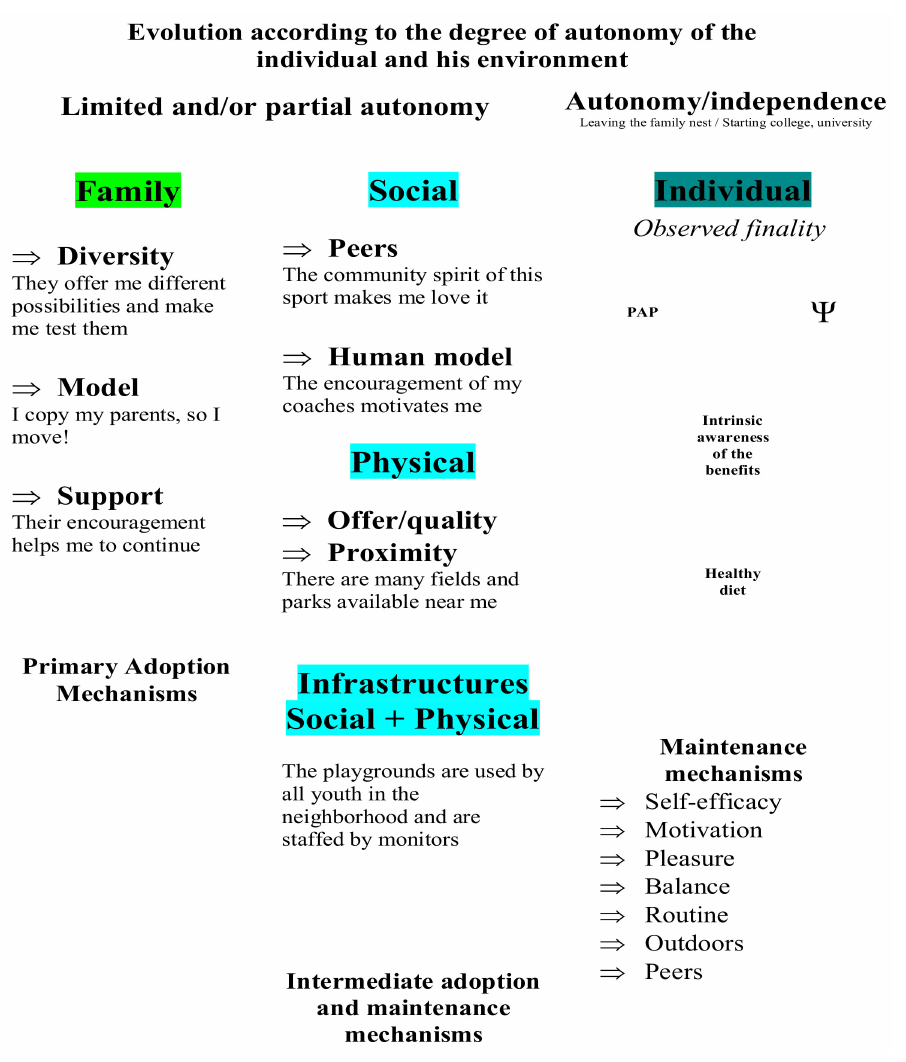
Figure 6. Conceptual model of evolutionary mechanisms of healthy lifestyle habit adoption and